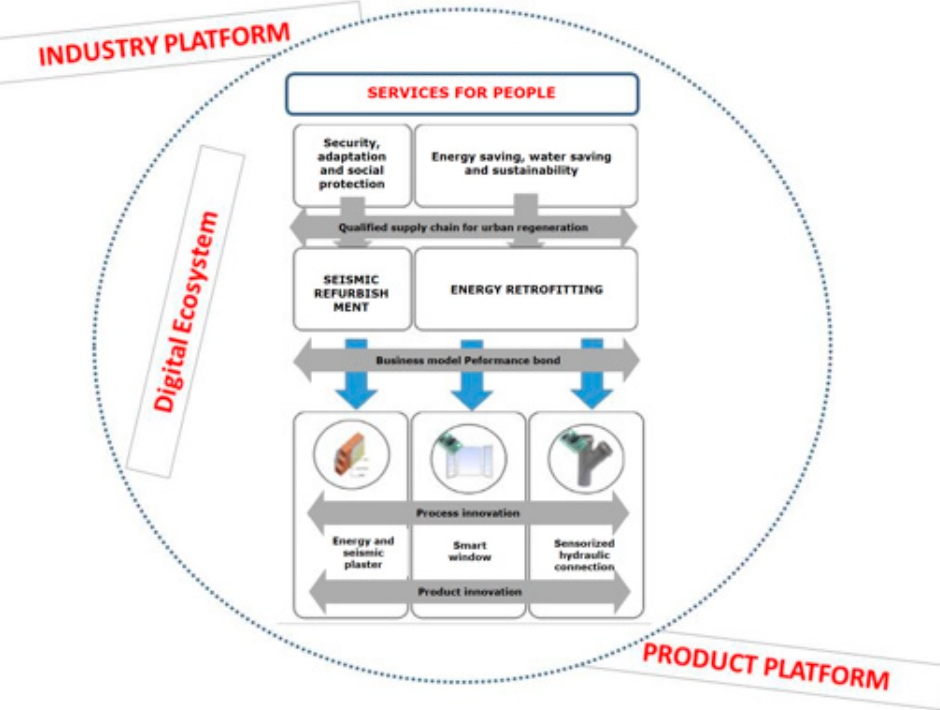
Figure 1. Energy, Life Styled, and Seismic Innovation for Regenerated Buildings (ELISIR) principles and concept structure.